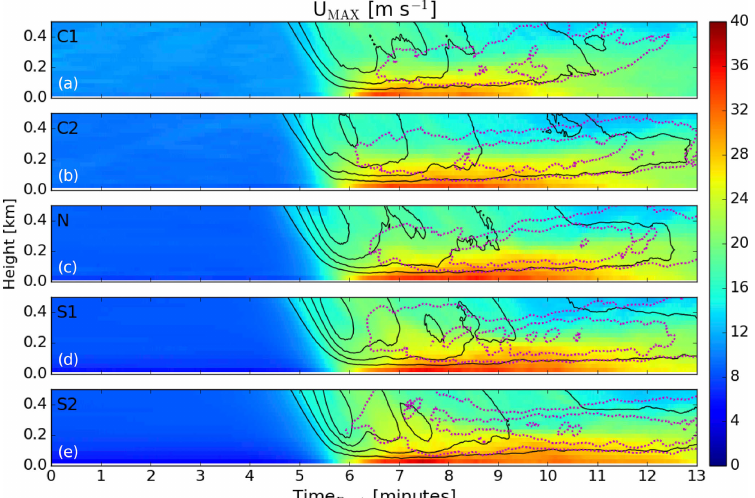
Figure 8. A time–height plot in the lowest 500m of the ensemble average of maximum horizontal velocity for the C1, C2, N, S1, and S2 cases going from panels (a–e) . Contoured (in black) are the ensemble averages of minimum vertical velocity starting from − 10ms − 1 and drawn at − 5ms − 1 intervals and (in dotted magenta) the ensemble averages of maximum vertical velocity starting from positive 10ms − 1 and drawn at 2.5ms − 1